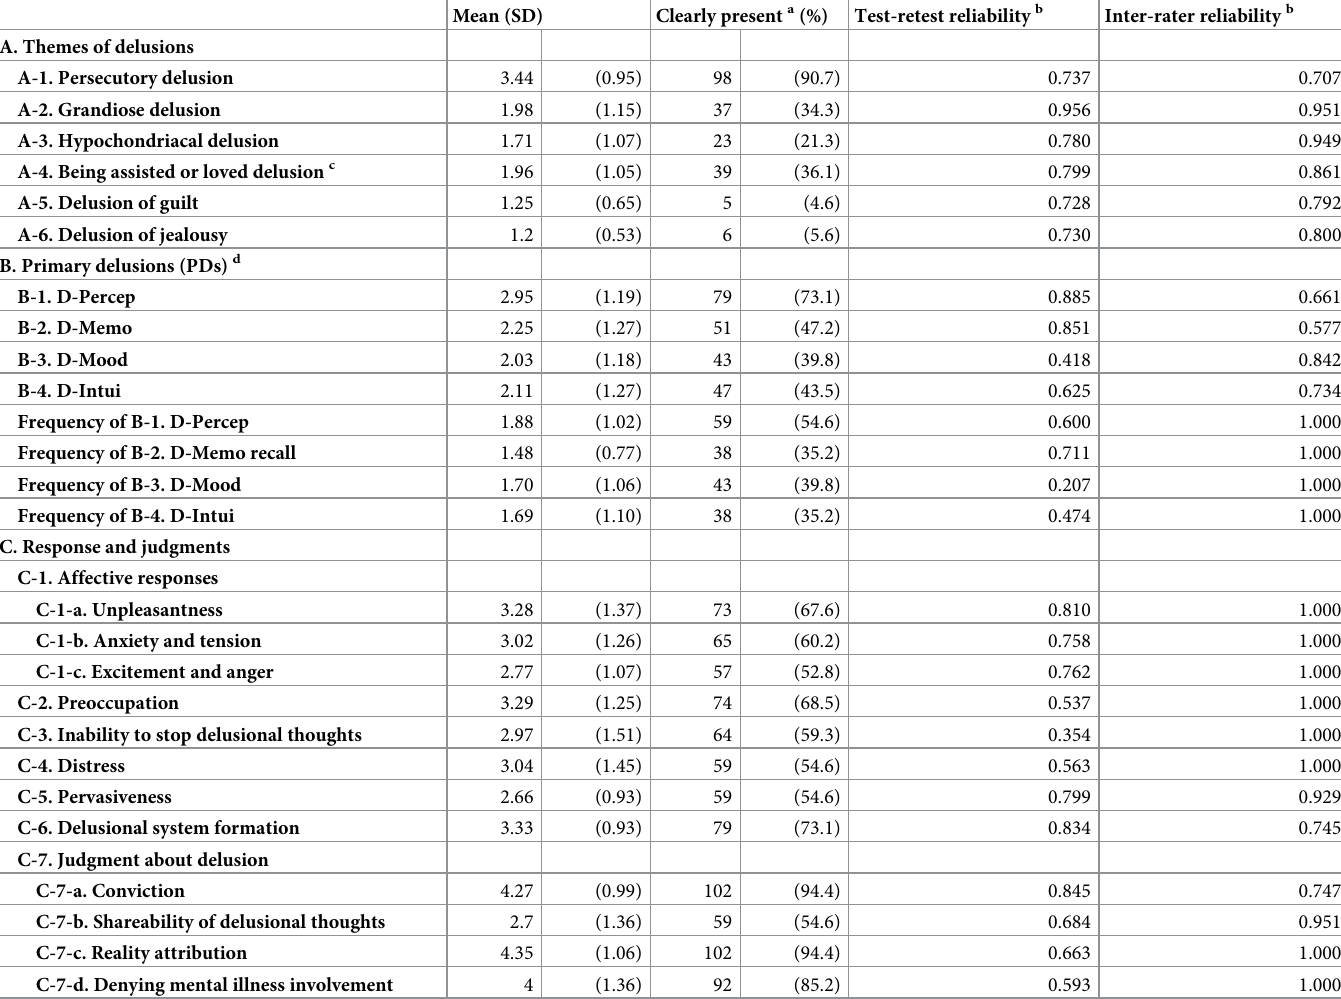
Table 2. Delusion and its Origin Assessment Interview (DOAI) item scores and the results of their reliability